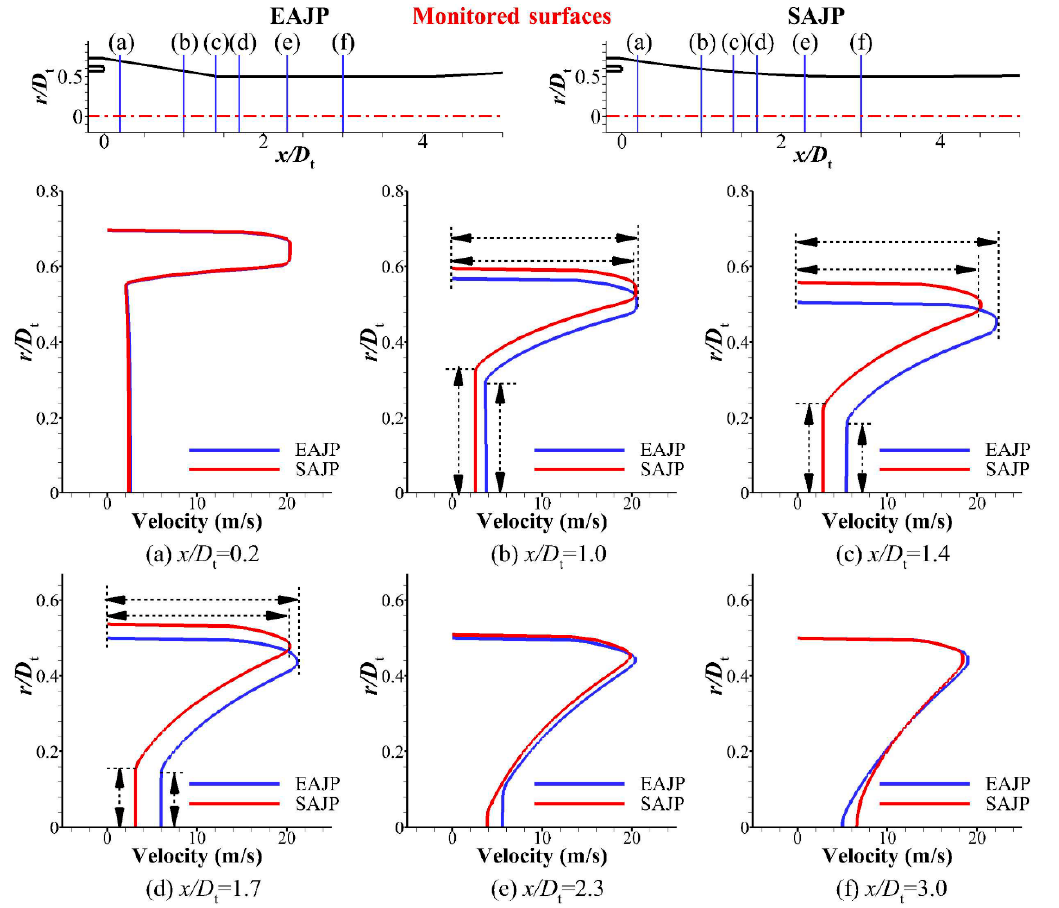
Figure 9. Velocity distribution of the cross-section ( q = 0.33).